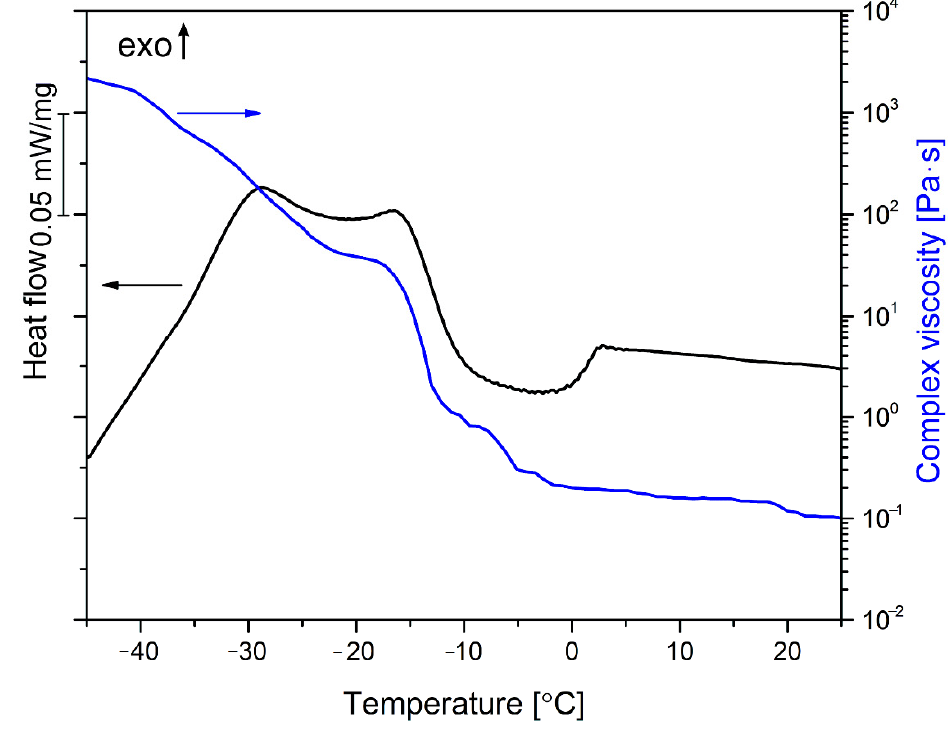
Figure 1. Changes of complex viscosity and the run of DSC curve for the linseed oil.